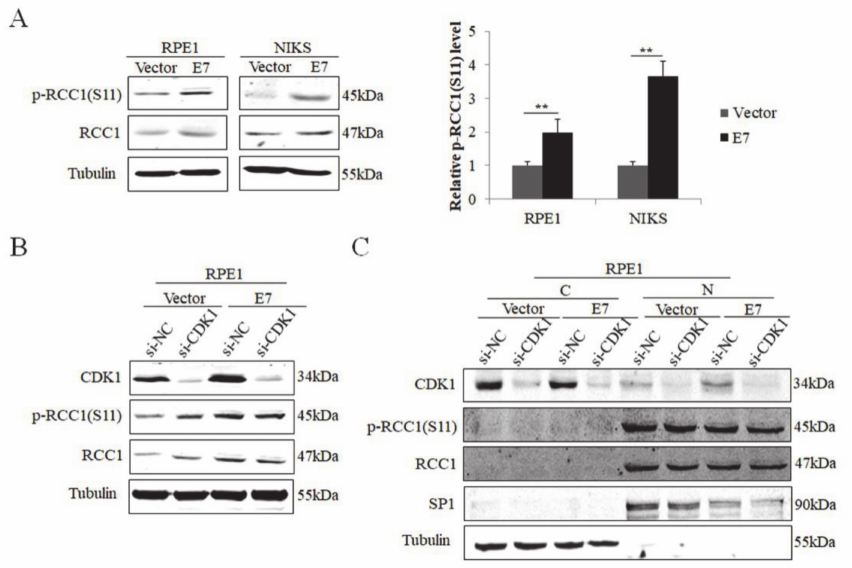
Figure 1. HPV E7 up-regulated phosphorylation of RCC1 S11 in CDK1-independent manner. ( A ) Western blot analysis of RCC1 and p-RCC1(S11) protein levels in HPV16 E7-expressing RPE1 and NIKS cells showed that p-RCC1(S11) was highly expressed in HPV16 E7-expressing cells. ( B ) CDK1, p-RCC1(S11), RCC1 protein levels were detected by Western blot following transfection with siRNA targeting CDK1. ( C ) Cellular localization of CDK1, p-RCC1(S11), RCC1 after transfection with siRNAs targeting CDK1 in both RPE1-Vector cells and RPE1-E7 cells. Data shown are representative of 3 biological replicates. ** p <